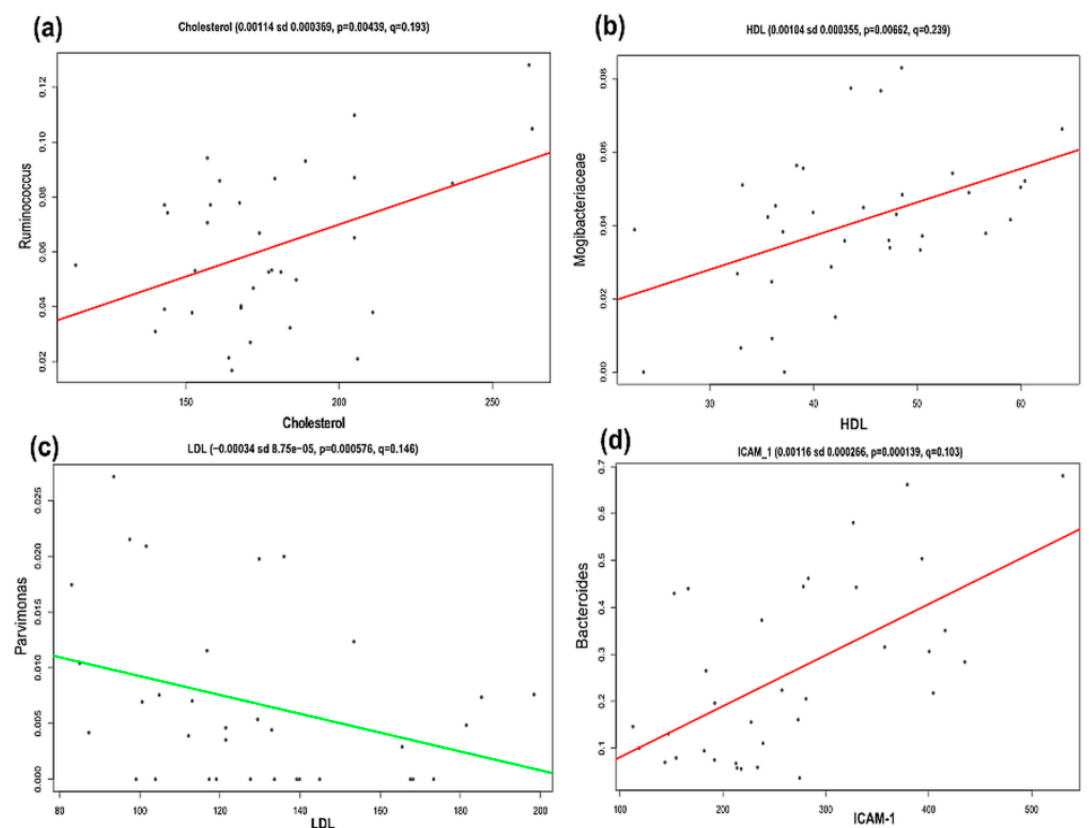
Figure 5. Multivariate linear associations of clinical metadata and bacterial relative abundance in obese adolescents. Scatter plot explains the significant association of Cholesterol with Ruminococcus ( a ), HDL with Mogibacteriaceae ( b ), LDL with Parvimonas ( c ), and ICAM-1 with Bacteroides ( d ), as described in Materials and Methods section and Table S7. p -values and FDR corrected q -values are assigned by MaAsLin (v0.0.4). y-axes show the relative abundance of gut microbiota; x-axes show the clinical metadata. Numerical data on top of each graphic are Coefficient (positive coefficient shows positive association, and negative coefficient shows negative association between metadata and gut microbiota), sd—standard deviation; e—times 10 is raised to the power of; p -values, and FDR corrected q -values which are assigned by MaAsLin (v0.0.4). HDL—high-density lipoprotein; LDL—low-density lipoprotein, and ICAM-1—intercellular adhesion molecule-1.